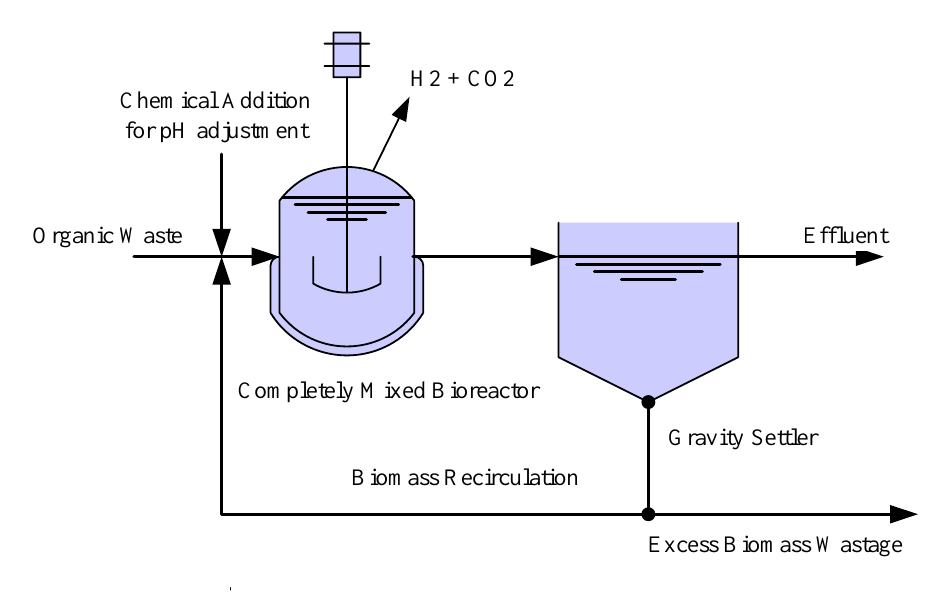
Figure 1. Experimental setup for the biohydrogenator.